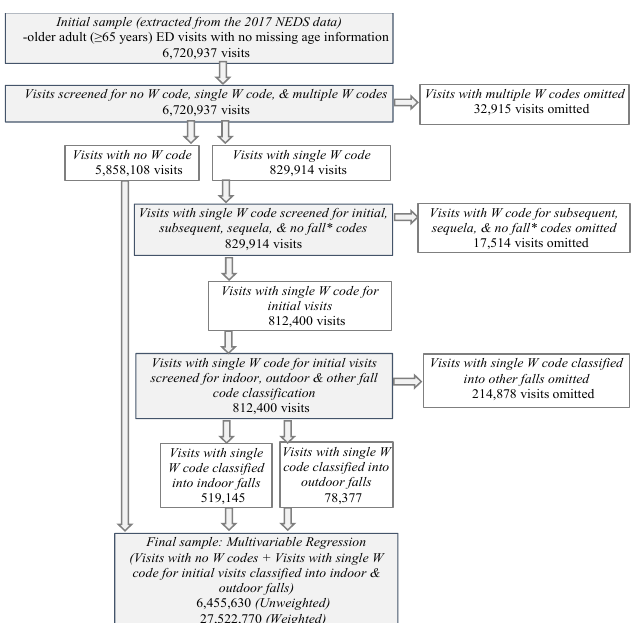
Figure 1. Sample extraction and selection/exclusion criteria using the Nationwide Emergency Department Sample (NEDS)